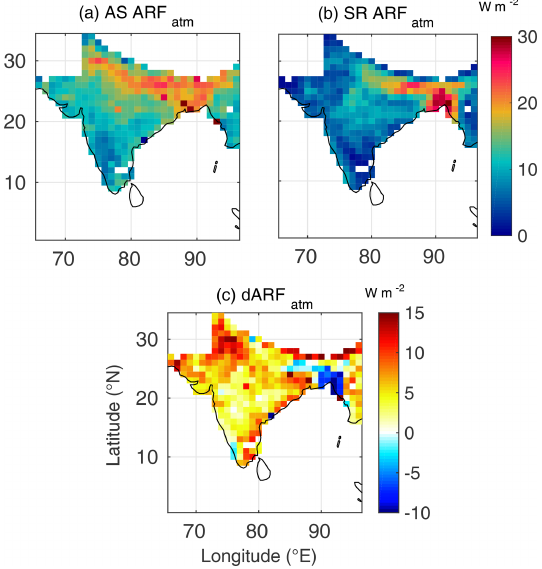
Figure 4. Spatial variation of (a) AS ARF atm (atmospheric forc- ing estimated using AS AOD and AS SSA), (b) SR ARF atm (at- mospheric forcing estimated using SR AOD and SR SSA) and (c) dARF atm for January 2009.